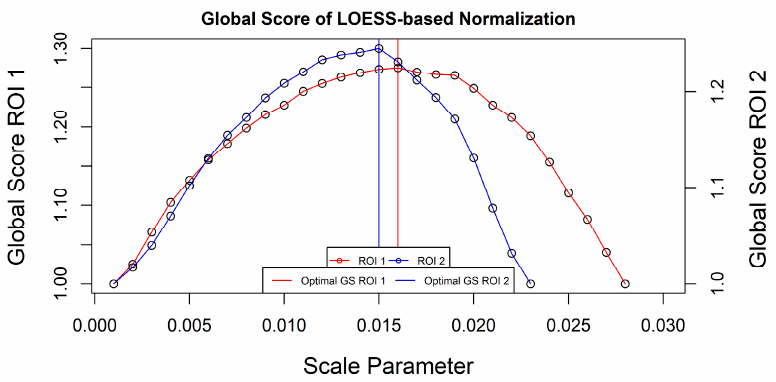
Figure 7. GS for each computed segmentation and ROI using the LOESS approach.